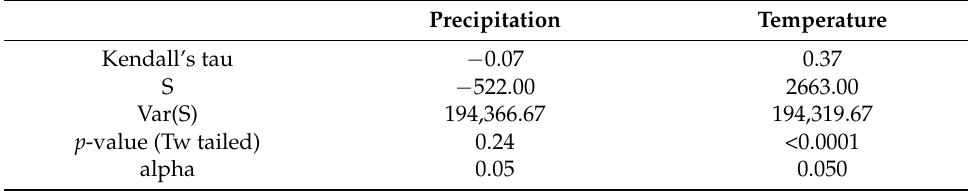
Table 1. Mann – Kendall trend tests for precipitation and temperature in Zimbabwe.